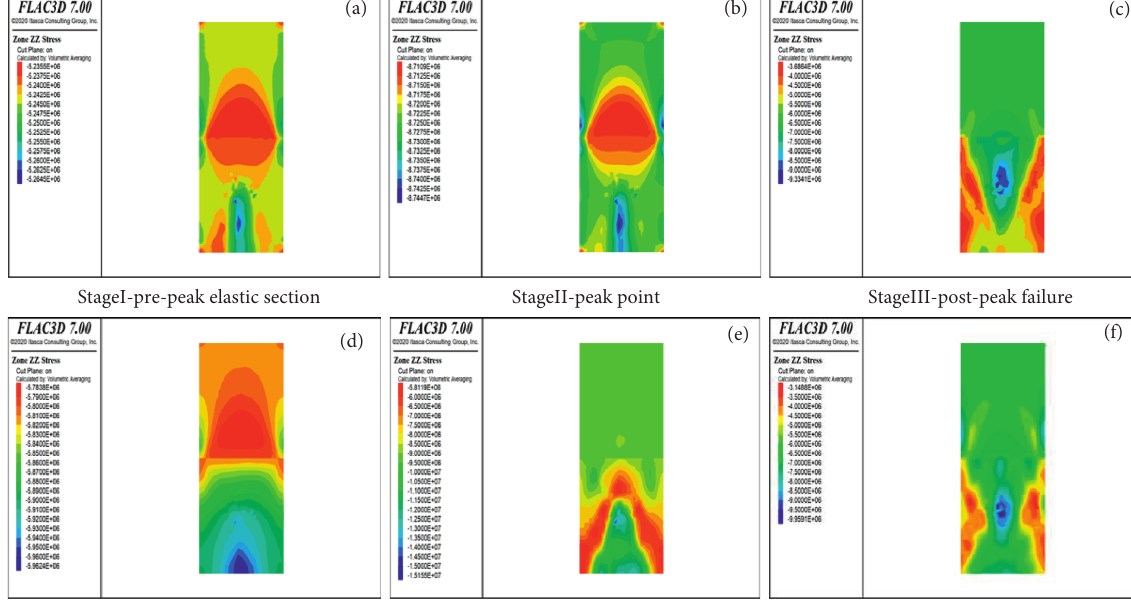
Figure 4: Vertical stress distribution under different conditions.